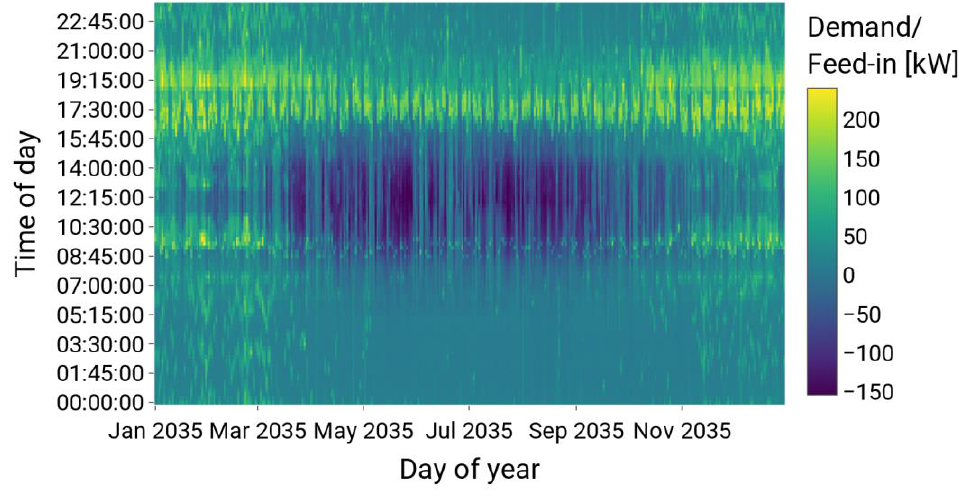
Figure 6. Heatmap of the electric demand (positive values) and feed-in (negative values) for the business-as-usual scenario, the scenario year 2035 and the rural grid.